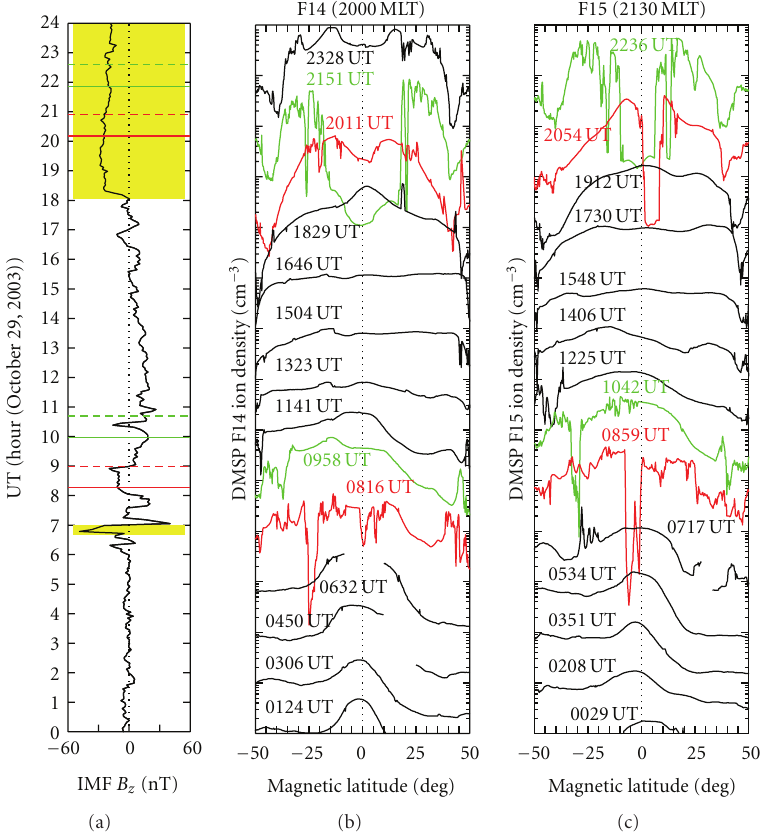
Figure 2: Occurrence of equatorial plasma bubbles during the periods of southward IMF on 29 October 2003. Figures 2(a)–2(c) show the IMF B z and the ionospheric ion density measured by the DMSP F14 and F15 satellites, respectively.